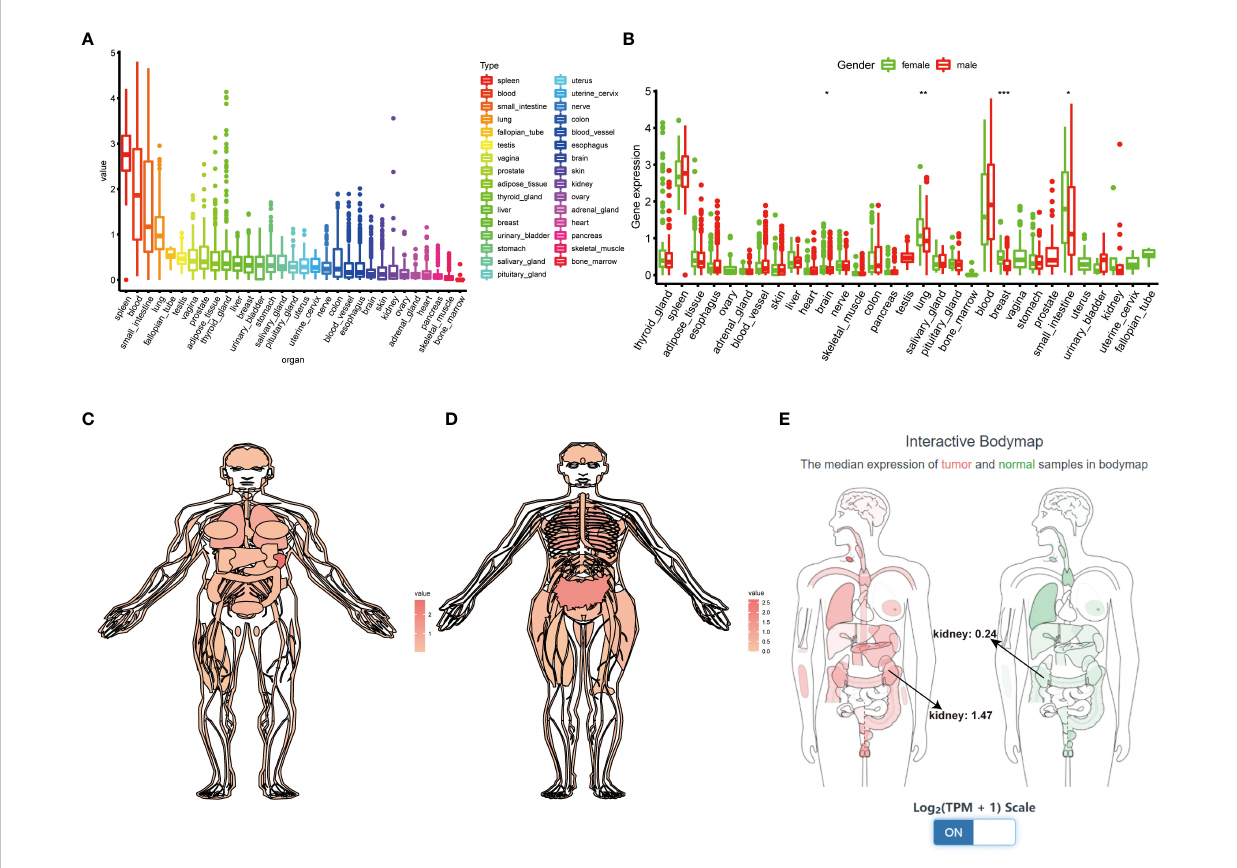
FIGURE 3 Comprehensive analysis of TIGIT in whole-body ’ s normal tissues. (A) The expression status of TIGIT in normal organs sorted by the expression value. (B) The differential expression status of TIGIT between males and females. (C) The expression atlas of TIGIT in males. (D) The expression atlas of TIGIT in females. (E) The expression of TIGIT in tumor organ tissues (red) and normal organ tissues (green). *: p<0.05, **: p<0.01, ***: